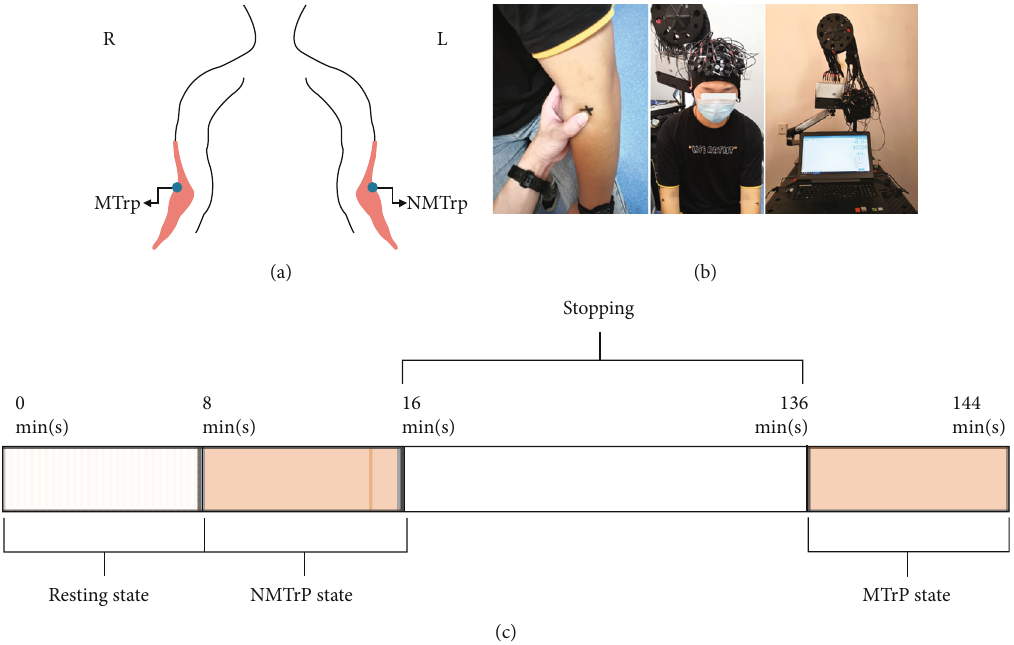
Figure 1: Schematic diagram of the experimental setup. (a) The distribution of MTrP and NMTrP: the marked blue regions of the bilateral brachioradialis muscle are the corresponding MTrP and NMTrP. (b) Experimental illustration. (c) Experimental schedule. NMTrP: nonmyofascial trigger point; MTrP: myofascial trigger point. Abbreviations: min(s),